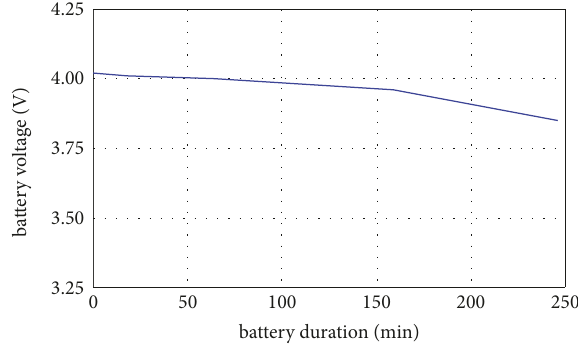
Figure 10: Temperature sensor battery discharge cycle measured for the first 250